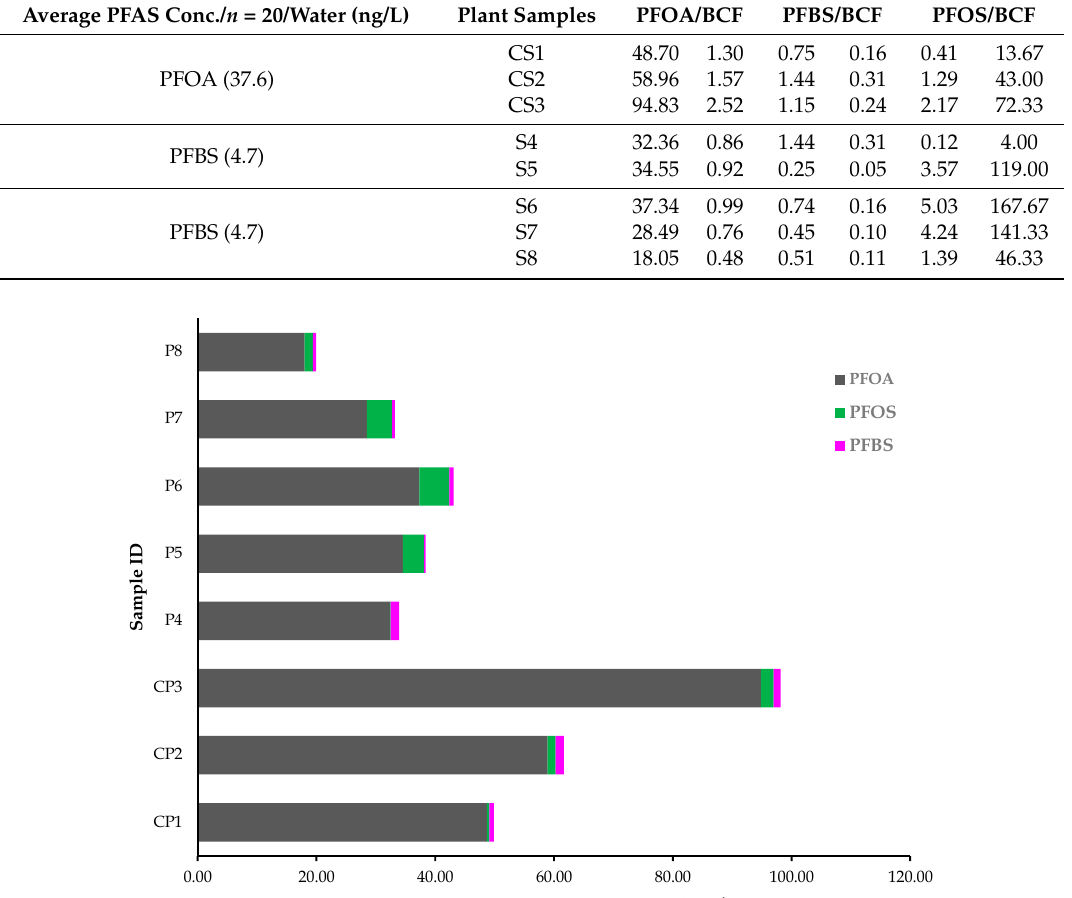
Figure 4. Contribution of each sample to the PFASs concentration levels in Tagetes erecta L.